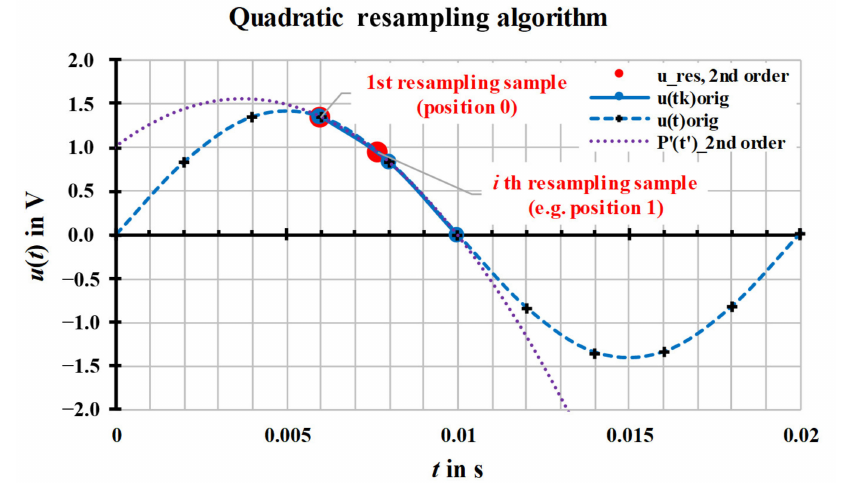
Figure A1. Detailed figure for calculating sample(s) based on a quadratic interpolation. The signals are simulated with parameters of f S = 500 Hz, T W = 1 s, U 1 = 1 V, f 1 = 50.1 Hz, ϕ 1 = 0 grad, and T Del = 0.005 s without any noise or any harmonics. The blue dashed curve with the black crosses represents the waveform of the sampling signal sequence. The three blue dots represent the selected sampling samples for the resampling process. The purple dotted curve represents the determined quadratic function. The red dots represent two resampling